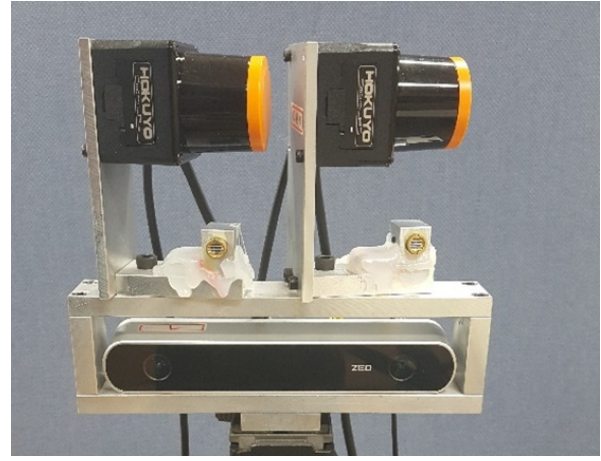
Figure 1. Dump truck cargo box 3D position recognition system.